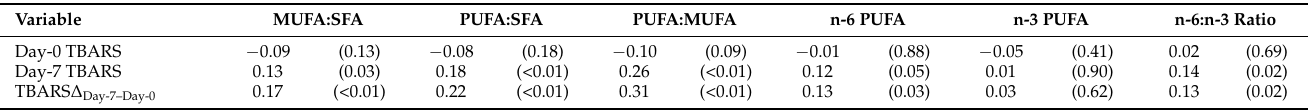
Table 6. Pearson correlation coefficients (r) for fatty acid profile (g/100 g fat tissue) with rate of lipid oxidation during a simulated retail